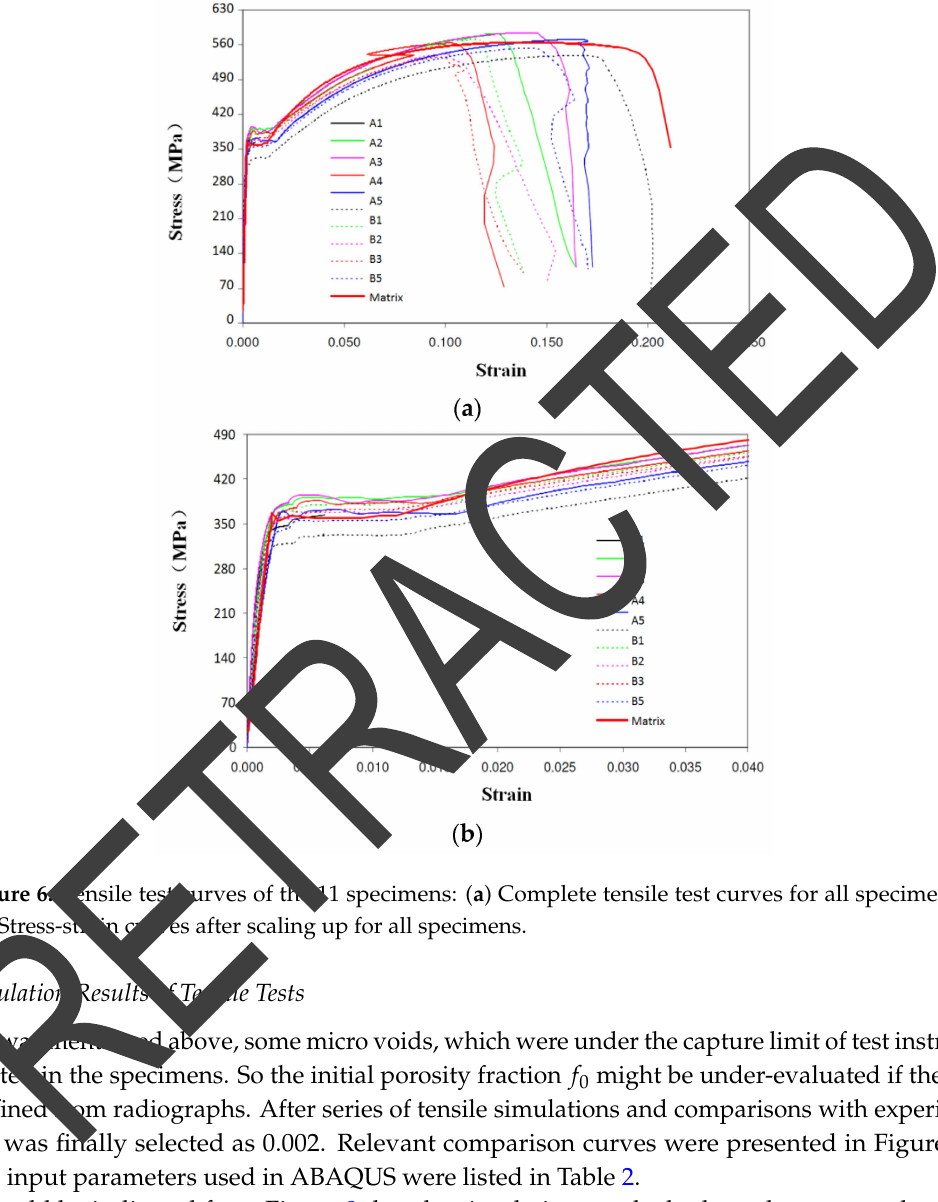
Figure 6. Tensile test curves of the 11 specimens: ( a ) Complete tensile test curves for all specimens; ( b ) Stress-strain curves after scaling up for all